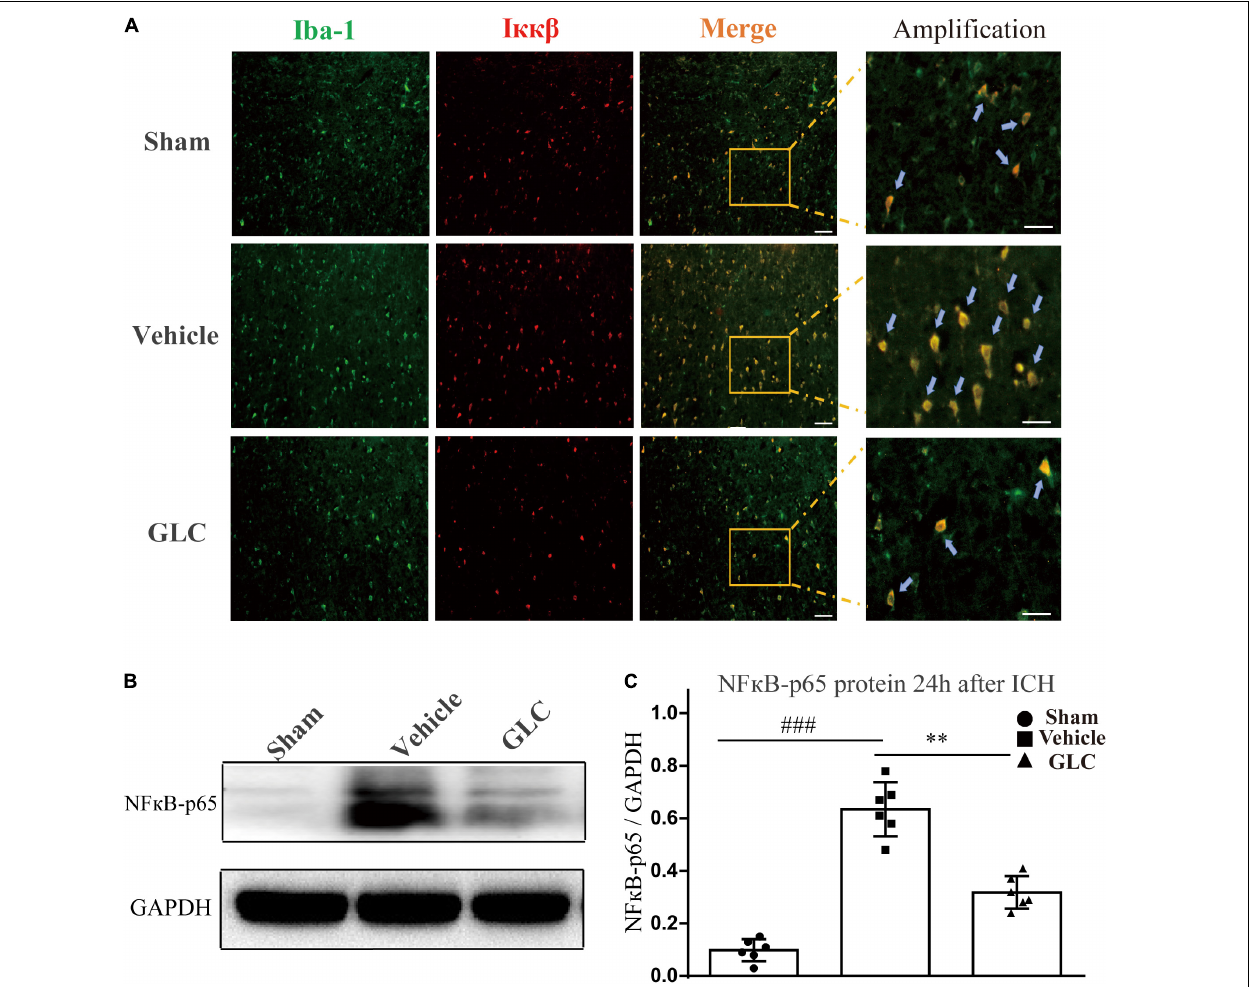
FIGURE 5 | The regulatory effect of glibenclamide (GLC) on the NF- κ B signaling pathway after intracerebral hemorrhage (ICH). (A) GLC reduced microglial secretion of Ikappa-B kinase (IKK β ) ( n = 6). Bar = 20 µ m. (B,C) Western blot analysis and quantification of the mean density of the nuclear factor (NF)- κ B-p65 (65 kDa) band surrounding the hematoma 24 h after ICH (six rats/group), vehicle vs. sham ### p < 0.001, vs. GLC ∗∗ p < 0.01. Amplified regions were marked with “squares”. Iba-1 co-localized with Ikk β were marked with